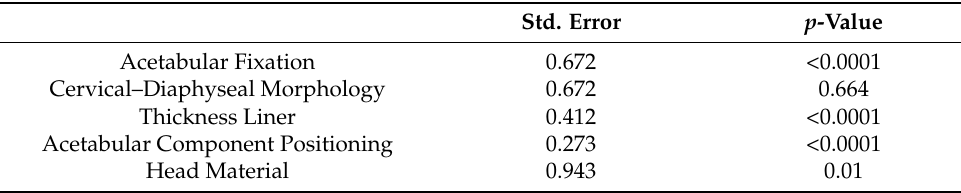
Table 4. Statistical coefficients for von Mises stress and dependent